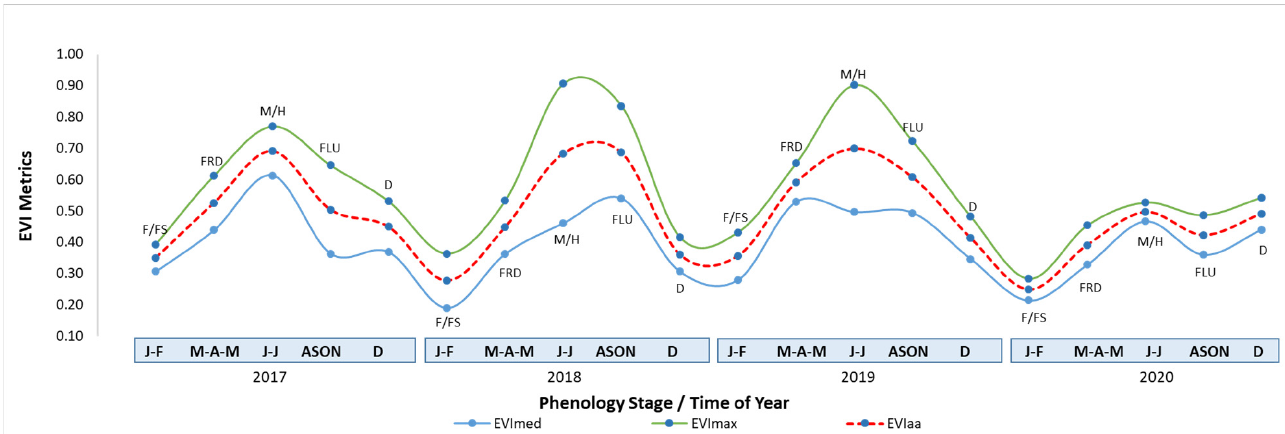
Figure 5. Temporal profile of mango in relation to the phenology cycle across the 4-year time series of median and maximum EVI metrics (EVI med , EVI max ) together with their overall yearly average (EVI aa ) from the Abora Farm.